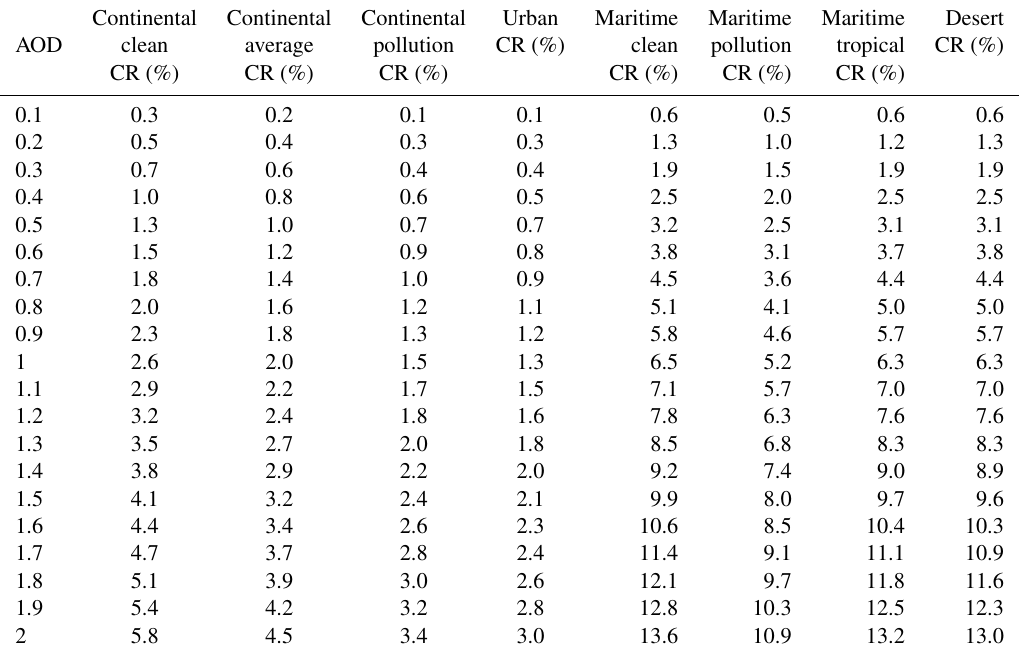
Table B1. Numerical values of the CR (%) simulations for SZA 30 ◦ at sea level for AOD values between 0 and 2, at 500nm, for different types of aerosols for FOV of 5 ◦